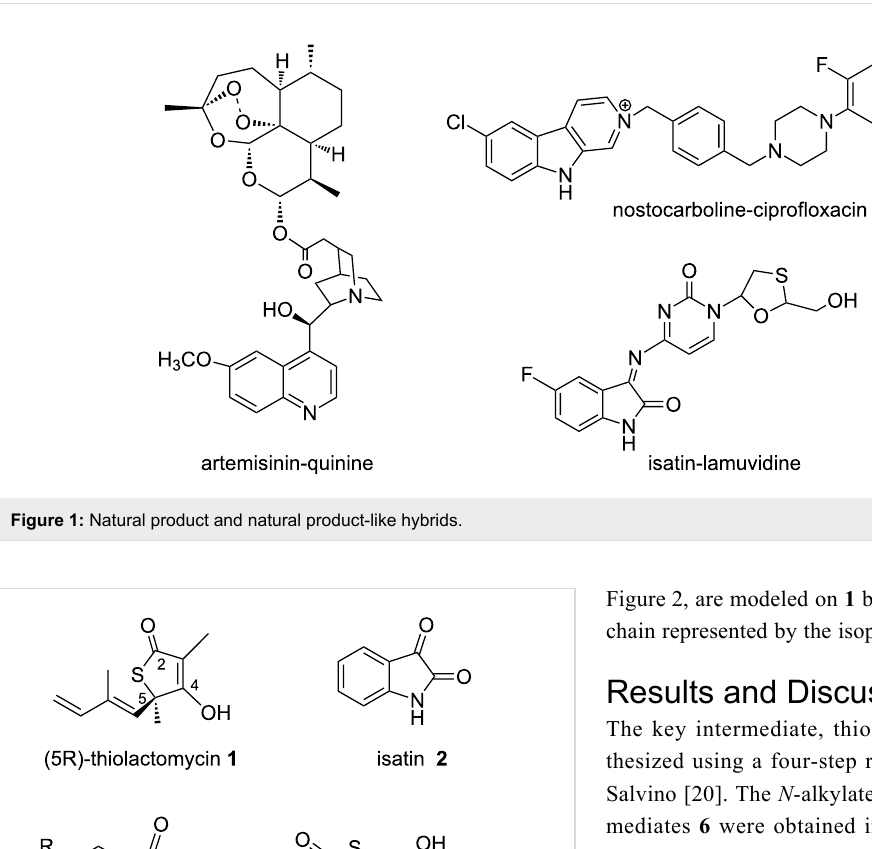
Figure 2, are modeled on 1 but devoid of the hydrophobic side chain represented by the isoprenoid moiety at